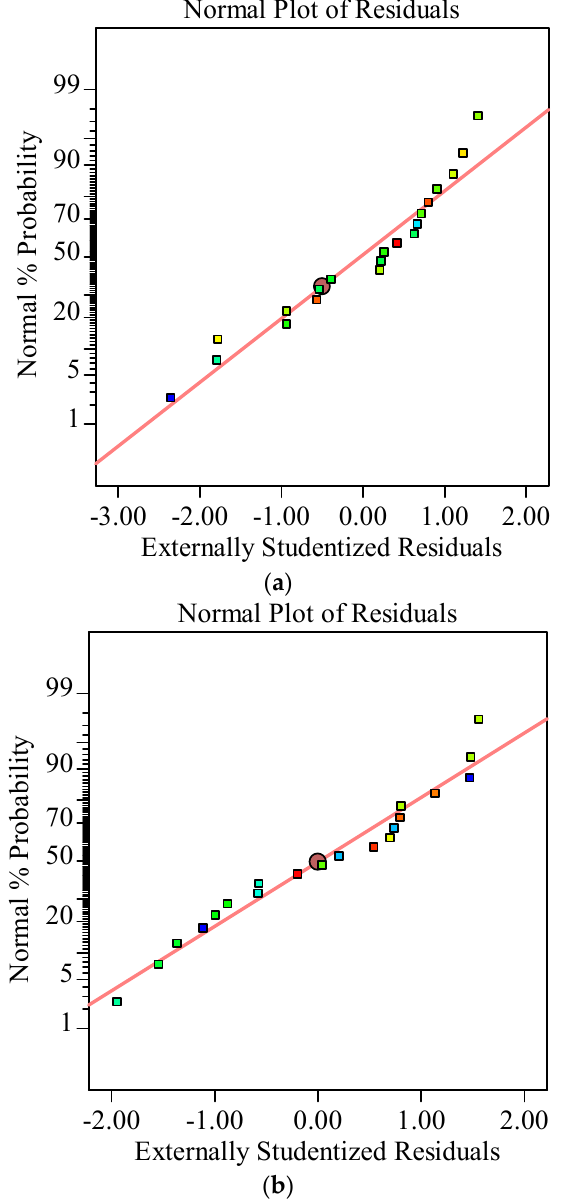
Figure 2. Normal probability plot of residuals for the model.( a ) dilution rate; ( b ) bead height.